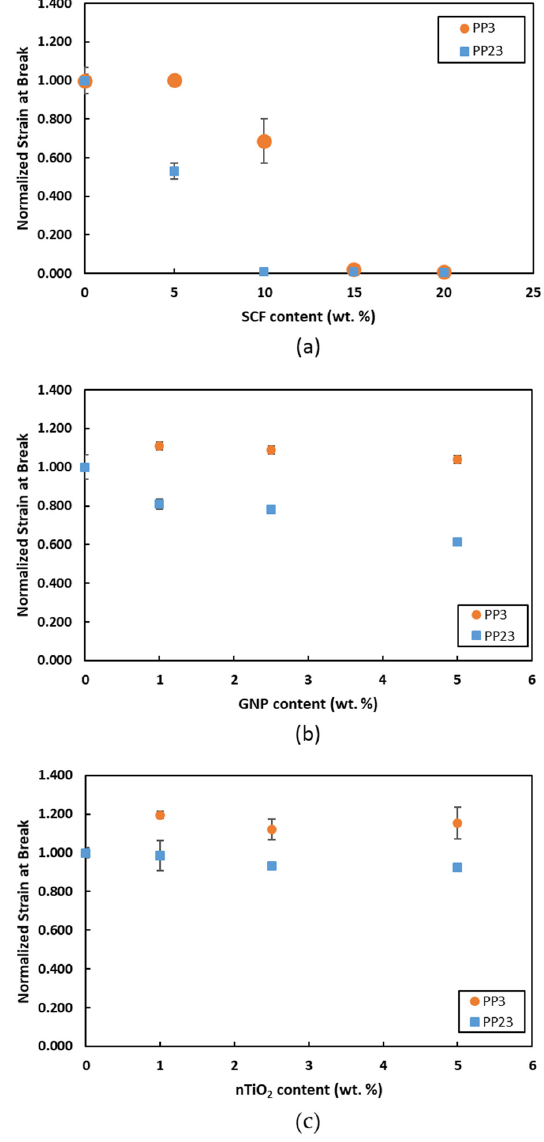
Figure 12. Normalized strain at break of ( a ) PP/SCF, ( b ) PP/GNP, and ( c ) PP/nTiO 2 composites.